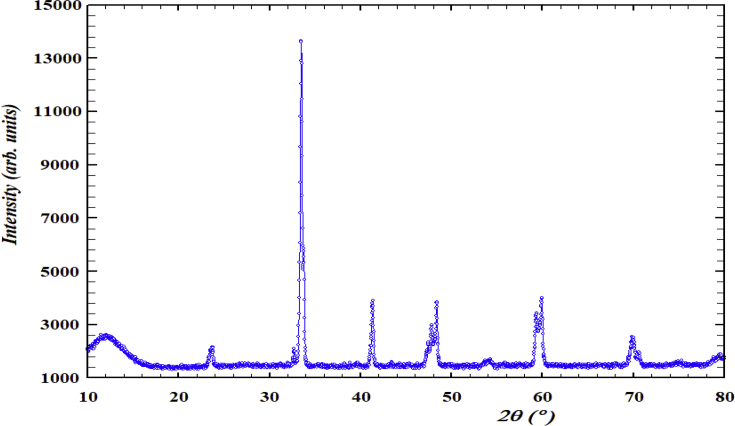
Raw XRD pattern of PrSrMn2O5+δ composition sintered at 1400 °C for 12 h in Ar.